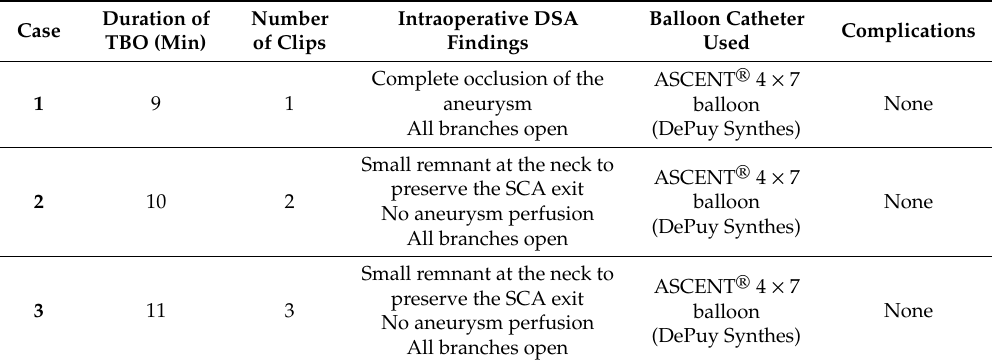
Table 2. Details of the intraoperative balloon occlusion procedure, clipping, and iDSA